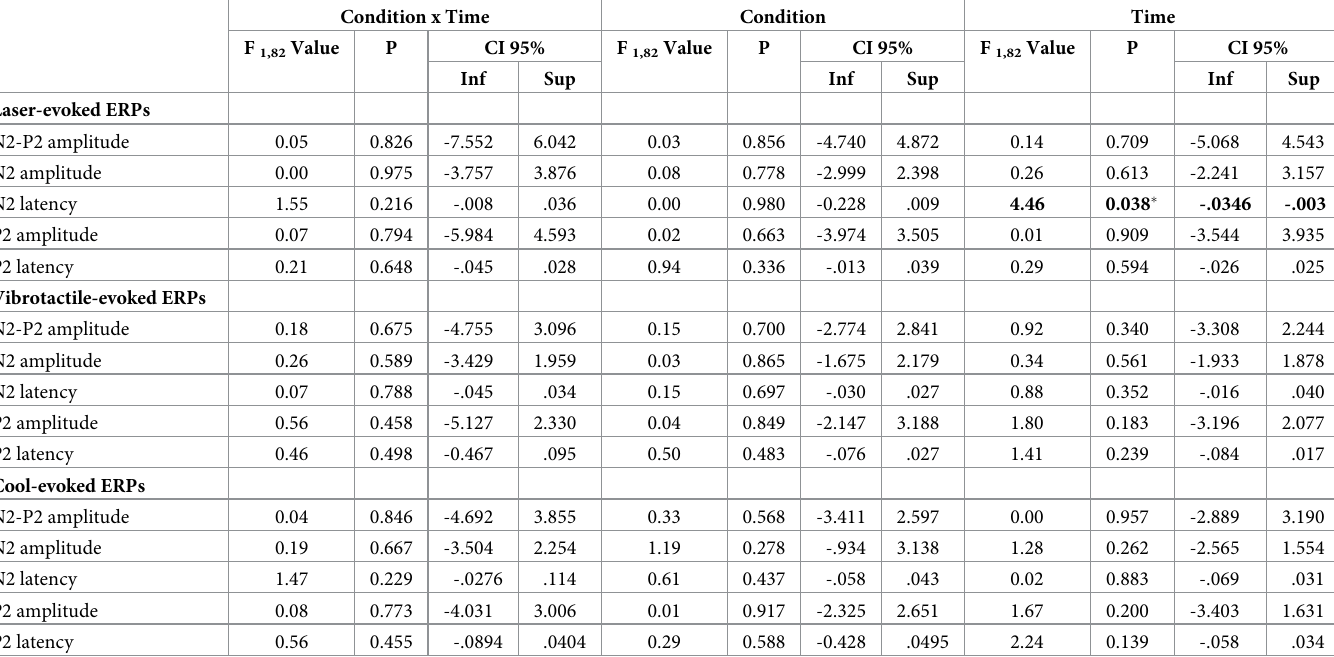
Table 5. Linear mixed models with within-subject factors ‘condition’ and ‘time’: Cerebral responses (Experiment 1). Condition x Time